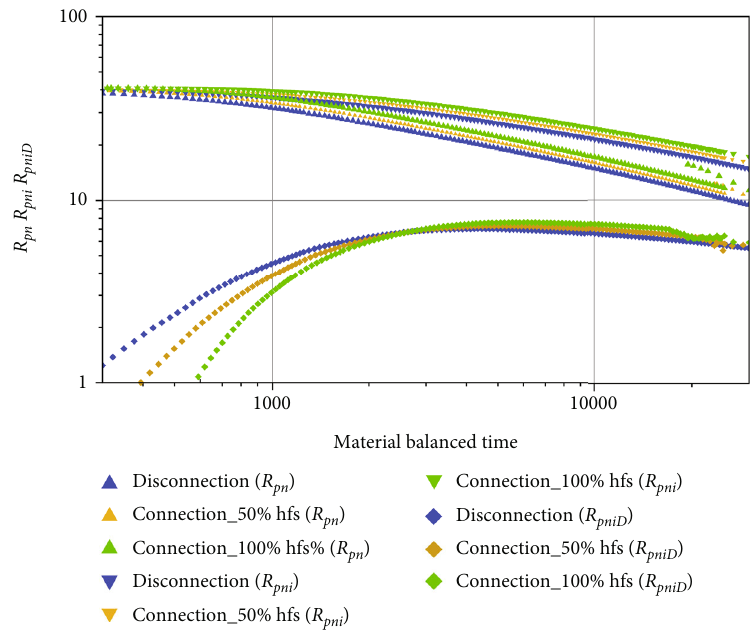
Figure 7: Blasingame type curves of di ff erent well connection conditions considering only hydraulic fractures.